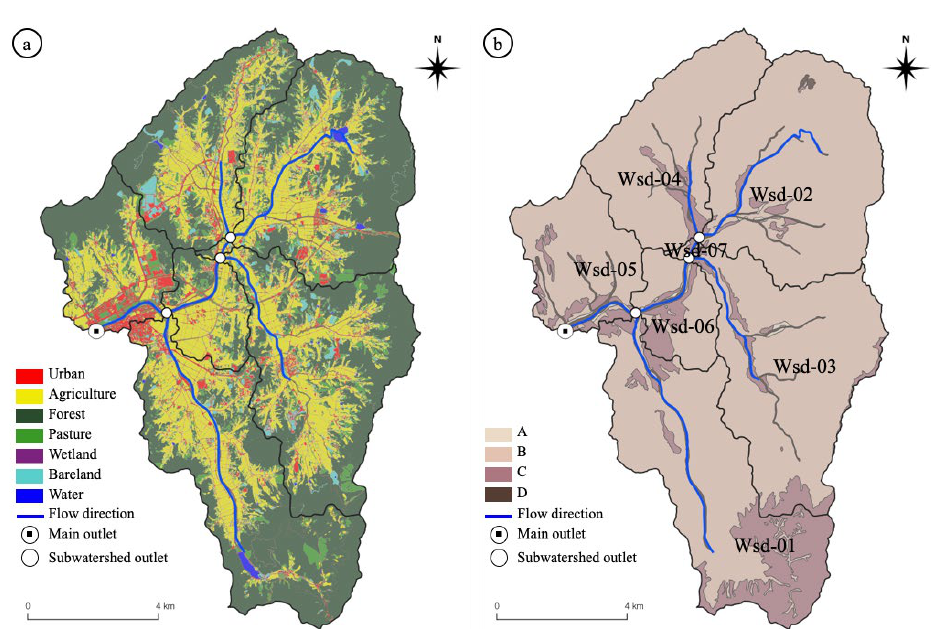
Figure 7. Watersheds where model was applied: ( a ) land use map; ( b ) HSG map. Table 1. Land use area of subwatersheds where model was applied.